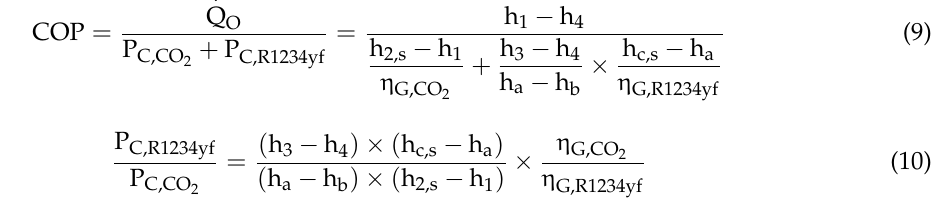
Figure 6. COP of the MS cycle at optimum conditions.